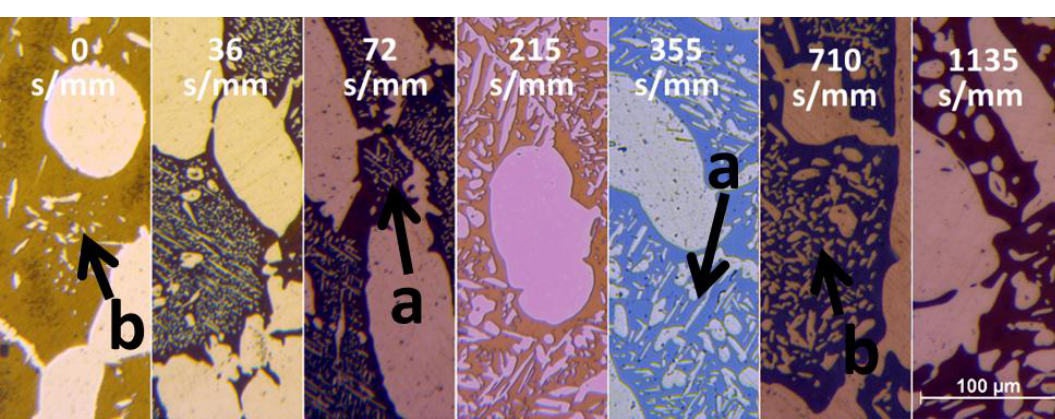
Figure 2. γ-Austenite content variation during isothermal annealing treatment assessed via metallographic method and sample micrographs of each stage of UNS S32760 evolution. The precipitation of γ-austenitic nuclei, as Widmannstätten precipitates ( a ) and via a martensitic shear process ( b ) within the α-ferritic matrix, is displayed in Reference [7].